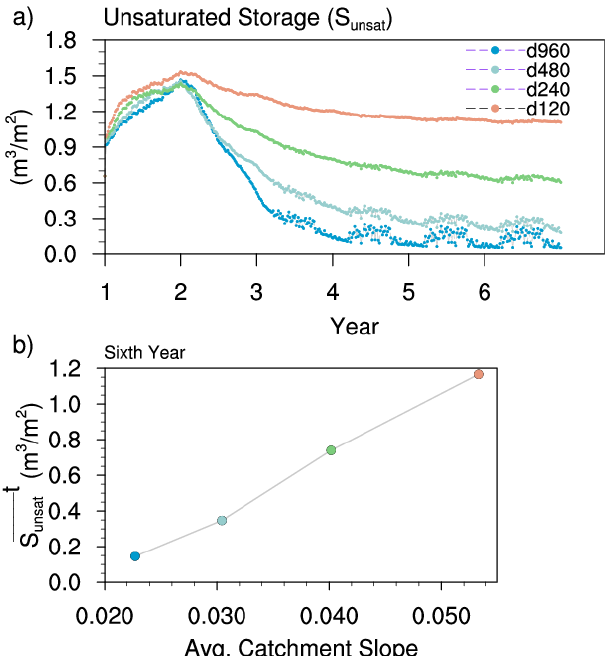
ment area ( S unsat ) for the sub-catchment at the four grid resolutions. (b) Relationship between the annual average unsaturated storage t ( S unsat ) and the average catchment slope for the four grid reso-